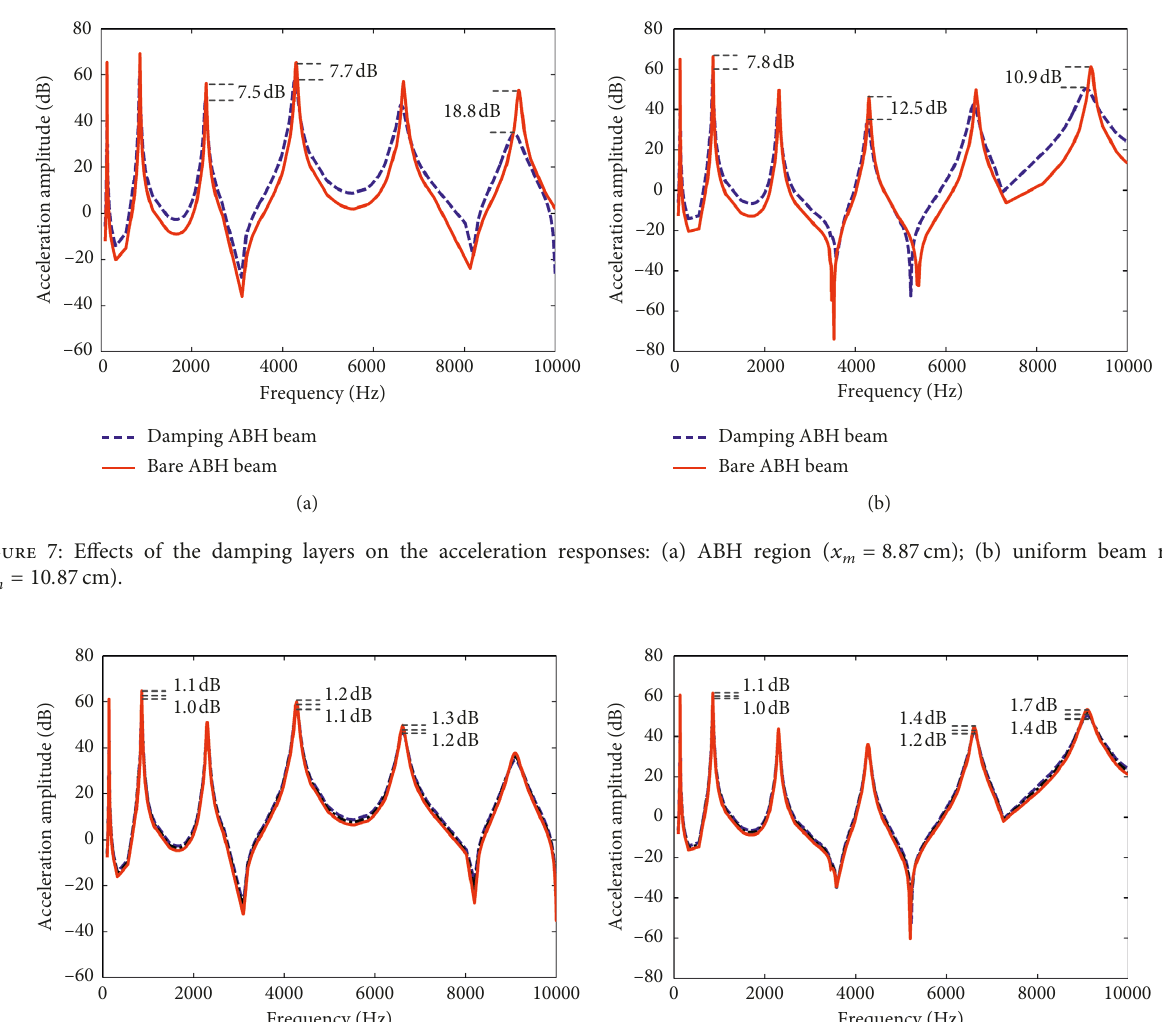
� 8 . 87 cm); (b) uniform m